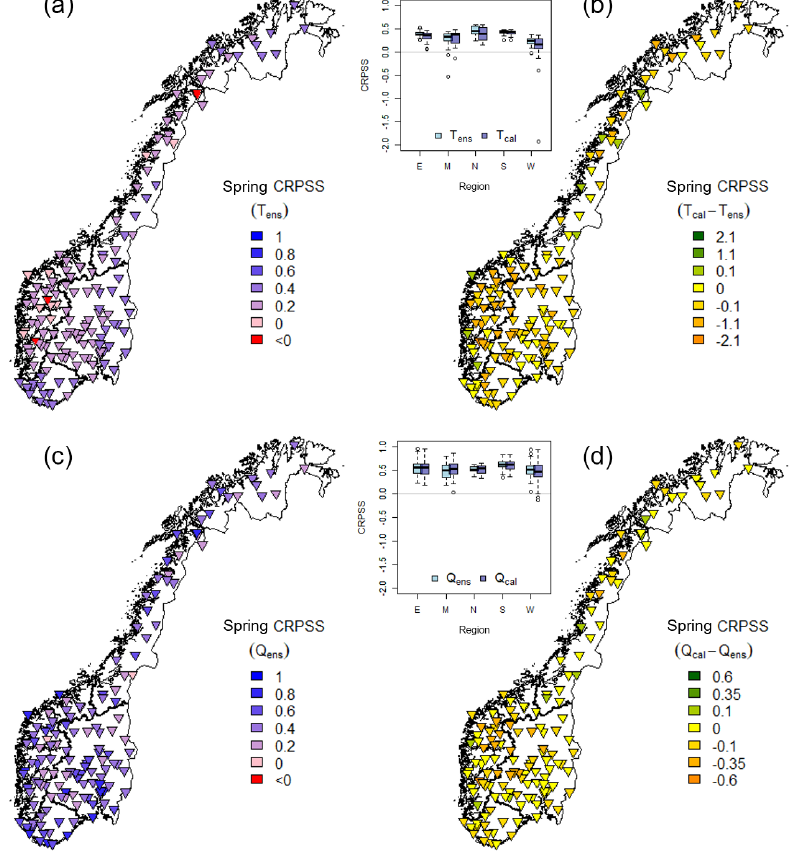
Figure 7. Spring CRPSS for uncalibrated forecasts (a, c) and CRPSS difference between calibrated and uncalibrated forecasts (b, d) for temperature (a, b) and streamflow (c, d) . A darker blue color (a, c) indicates an optimal performance (maximum CRPSS = 1.0), pink a CRPSS of zero, and red a negative value. A green color (b, d) indicates a positive effect of temperature calibration on the skill, yellow means no effect, and an orange color indicates a negative effect. The box plots show temperature and streamflow CRPSSs grouped by region (Fig. 1). All results are presented for a lead time of 5